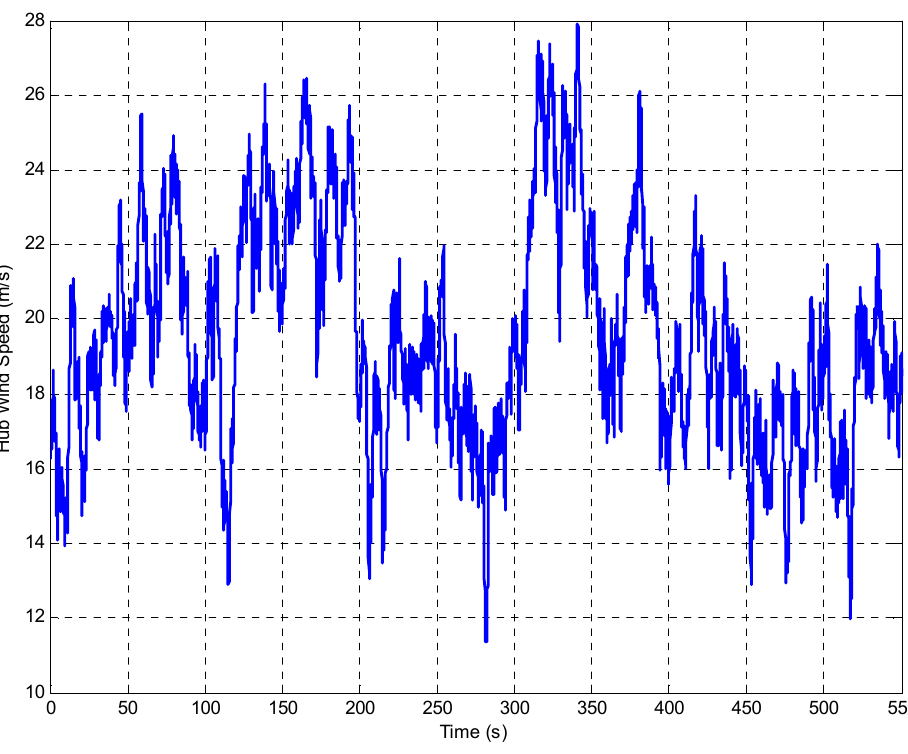
Figure 16. Hub wind speed for a turbulent production wind of 19